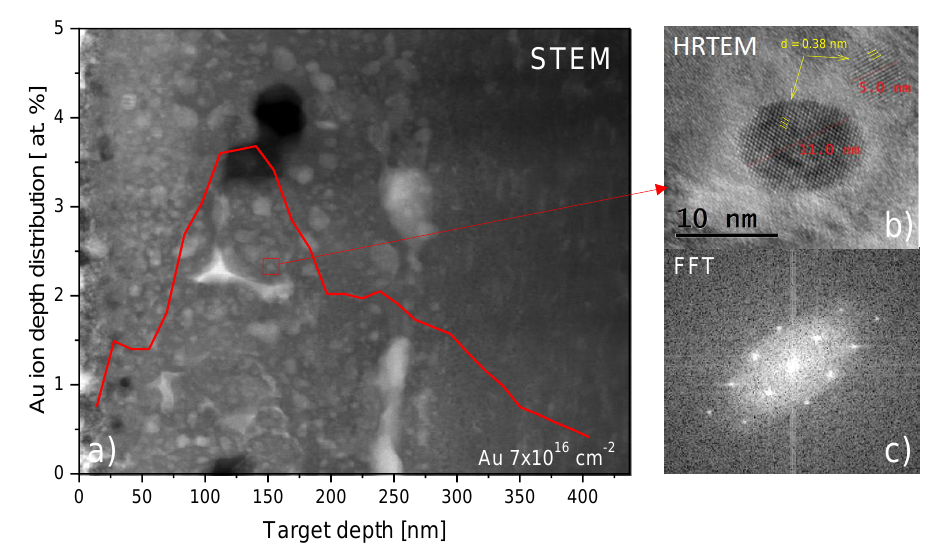
Fig. 3. Cross-sectional STEM image of GaN sample implanted with the Au-ion fluence 7×10 16 cm -2 after annealing in a) and HRTEM analysis of Au NPs with diffractogram in b) and corresponding FFT pattern of the bigger Au